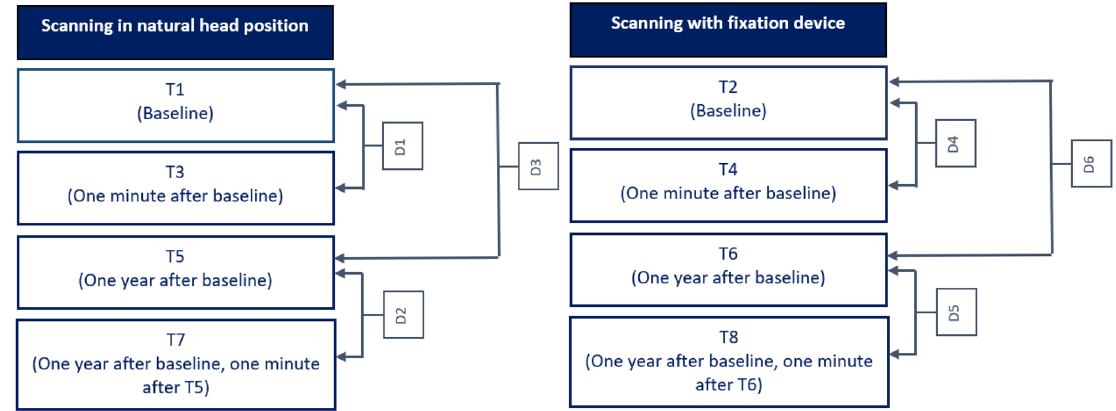
Figure 3. 3D scanning and comparisons of deviations between 3D-scans. ‘D’ indicates the deviation of the 3D-scans between the different measurements.